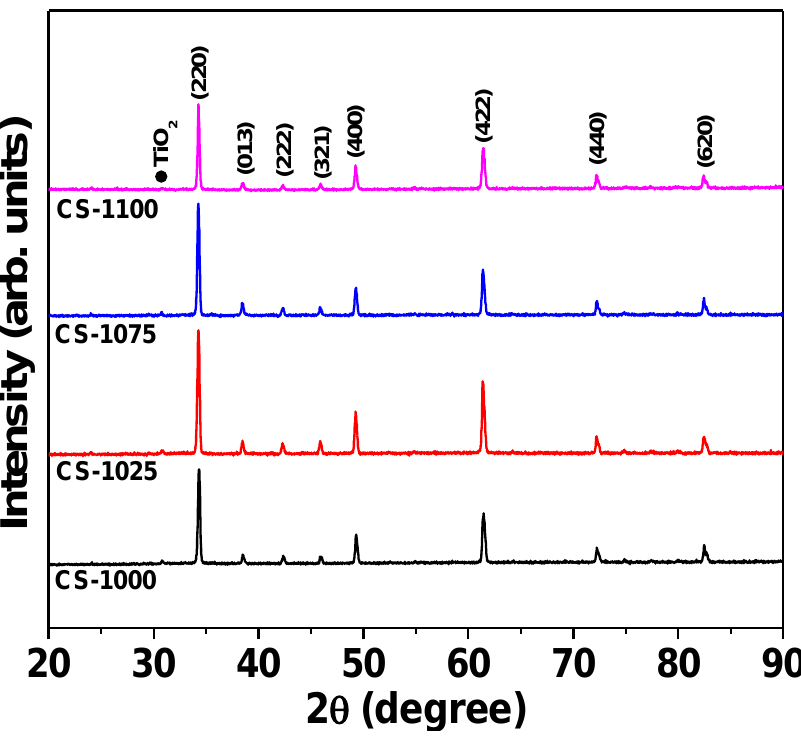
Figure 1. Room temperature XRD patterns of NSCTO ceramic samples. Table 1. The lattice parameter (c), the average crystallite size ( D ), lattice strain ( η ), and dislocation density ( δ ) of NSCTO